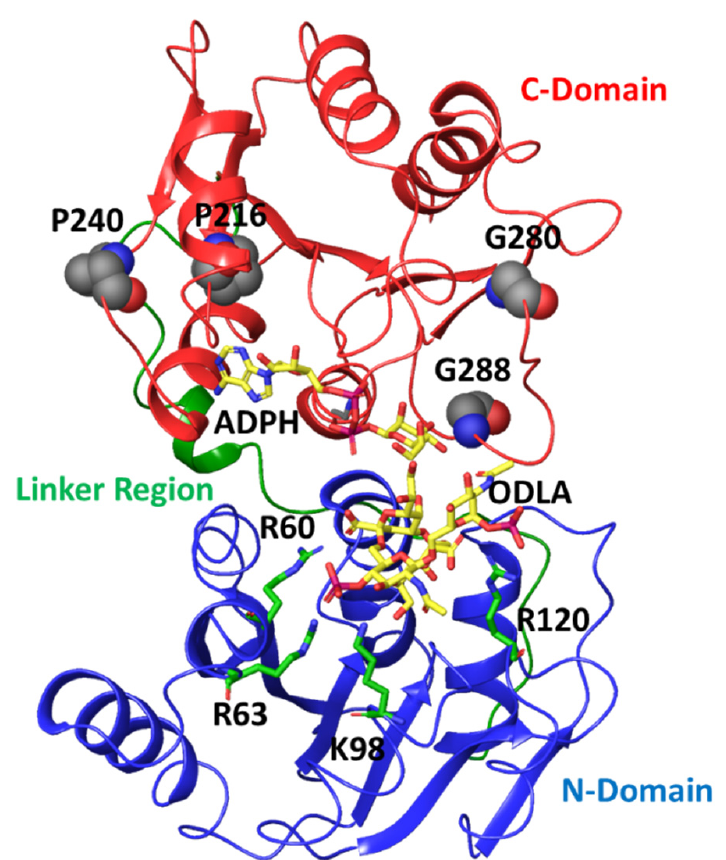
Figure 6. Crystal structure of HepI (PDB: 2H1H) with N domain, C domain and linker region colored in blue, red, green, respectively. The modeled ADPH and ODLA substrates (both in yellow) highlight the location of the catalytic site. The positively charged residues (R60, R63, K98 and R120) involved in FDLA binding are shown as stick representations. The four distal nonionizable residues (P216, P240, G280 and G288) located in the C-domain are shown in spacefill representation. This lead us to hypothesize that these residues were necessary for sensing the binding of the sugar donor substrate (ADP-L-glycero- D -manno-heptose, ADPH), with Pro 216 and Pro 240 recognizing bind of the adenosine portion and Gly 280 and Gly 288 sensing the heptose portion. Due to the inherent flexibility of residues Gly 280 and Gly 288 (as well as the large degree of fluctuation observed for these residues over the course of the simulation; Figure 2C) and the loop in which they occupy lead to the hypothesis that these residues could play a role of differentiating between the bound sugar donor substrate and the nucleotide product, and critical for water exclusion from the active site. As part of our future directions, simulations of the liganded complex will be pursued to test this hypothesis. In the interim, experimental and computational studies were performed to investigate the role of these residues in catalysis. These glycine residues were individually mutated to prolines, and these proline residues were individually mutated to glycine, so as to yield mutant proteins with the greatest possible perturbation of their conformational flexibility at each position. The resultant proteins were then expressed, purified and kinetically characterized using high concentration of the sugar donor substrate (ADPH) while varying concentrations of the sugar acceptor substrate (ODLA which binds to the N -terminal residues that previously showed a strong degree of correlation to these Pro and Gly residues) to assess the impact of these residues on its binding (Table